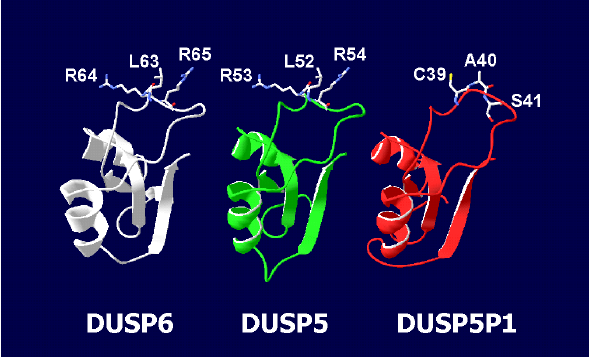
Figure 5. Homology modeling of a putative DUSP5P1 derived polypeptide. Presented is the result from an in silico homology modeling experiment using the substrate binding domain from DUSP6 [29] as template. The putative DUSP5P1 peptide (red) was predicted on the basis of a promoter scan followed by translation of all possible reading frames. This peptide (MLRKEAAAGW MVLGCRPYLA FTALSVPGSL NINLYSLVCA SPGRLWGQRA TCCQMPRSTL LLQEGSILAA VMVLN) is derived from the first open reading frame after the predicted transcription start site. In addition, the structure of the homologue region of DUSP5 (green) was predicted by using DUSP6 (white) as template. For better visibility, only the sequences from DUSP6 and DUSP5 corresponding to the predicted DUSP5P1 peptide are shown. Amino acids important for substrate binding by DUSP6 and the corresponding amino acids from DUSP5 and DUSP5P1 are highlighted.